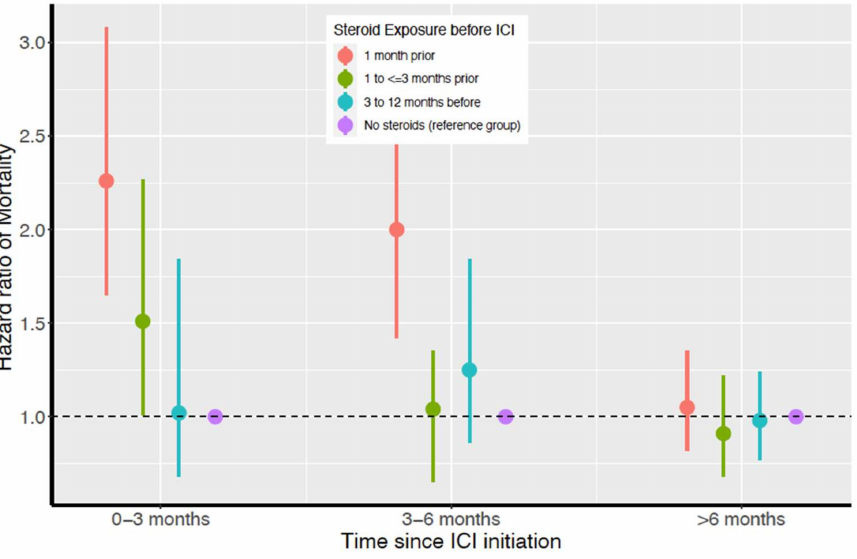
Figure 2. Time-dependent all-cause mortality hazard ratios for all steroid-exposure groups and survival time periods. Table 2. Steroid-exposure timing prior to ICI initiation and its time-dependent association with all-cause mortality after ICI